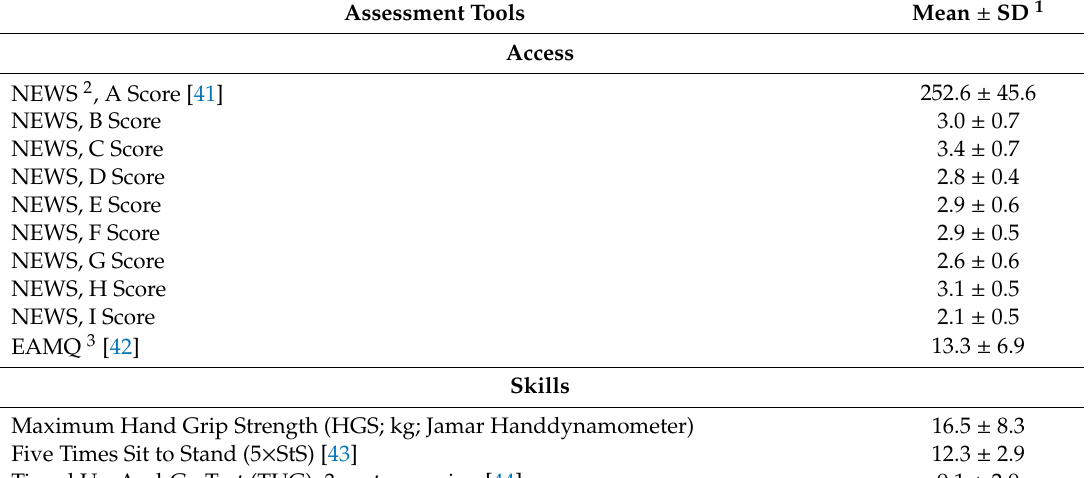
Table 3. Descriptive statistics of the factors of